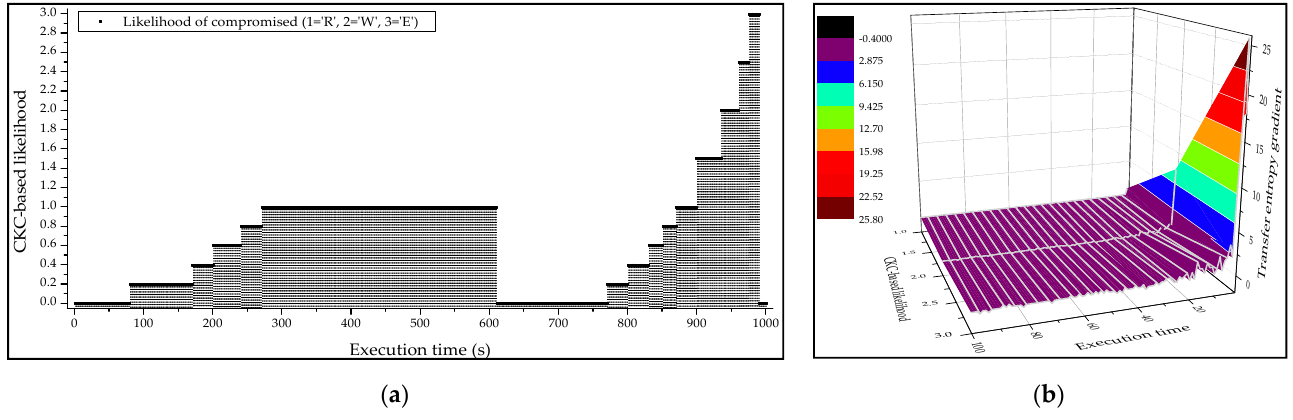
Figure 10. CKC-based compromise likelihood and multi-dimensional entropy-based results in the IODA simulation. ( a ) CKC phases based on reconnaissance, weaponization and exploitation, ( b ) transfer entropy-based operational surfaces.